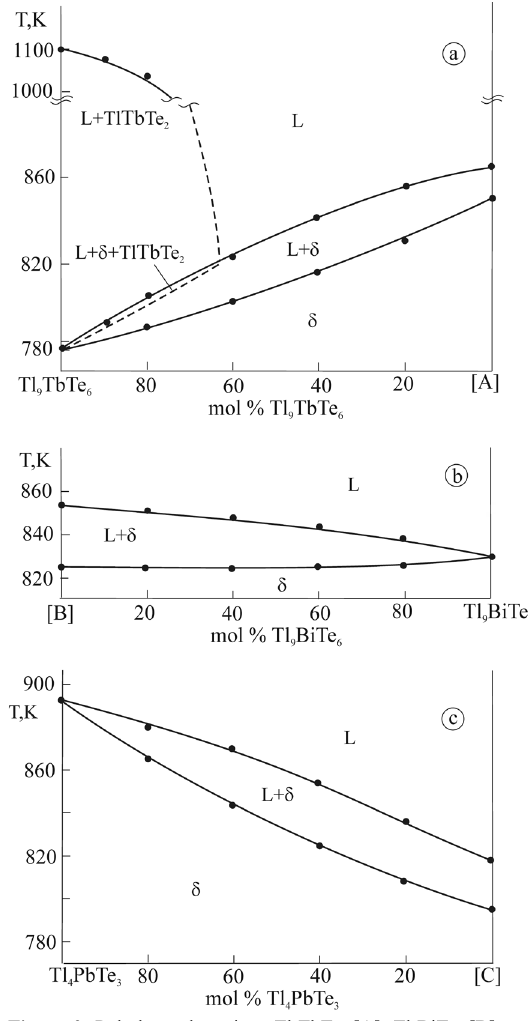
Figure 3. Polythermal sections Tl